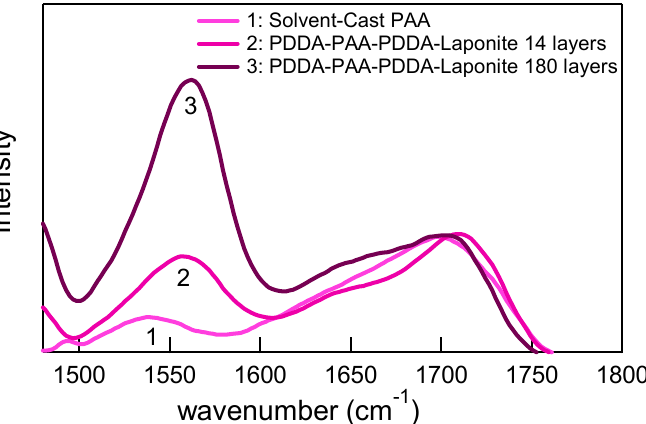
Figure 6. FTIR spectra of solvent-cast PAA and PDDA-PAA-PDDA-Laponite films of 14 layers and 180 layers. The peak at ~1700 cm − 1 corresponds to –COOH groups, and the peak at ~1550 cm − 1 corresponds to –COO − groups.